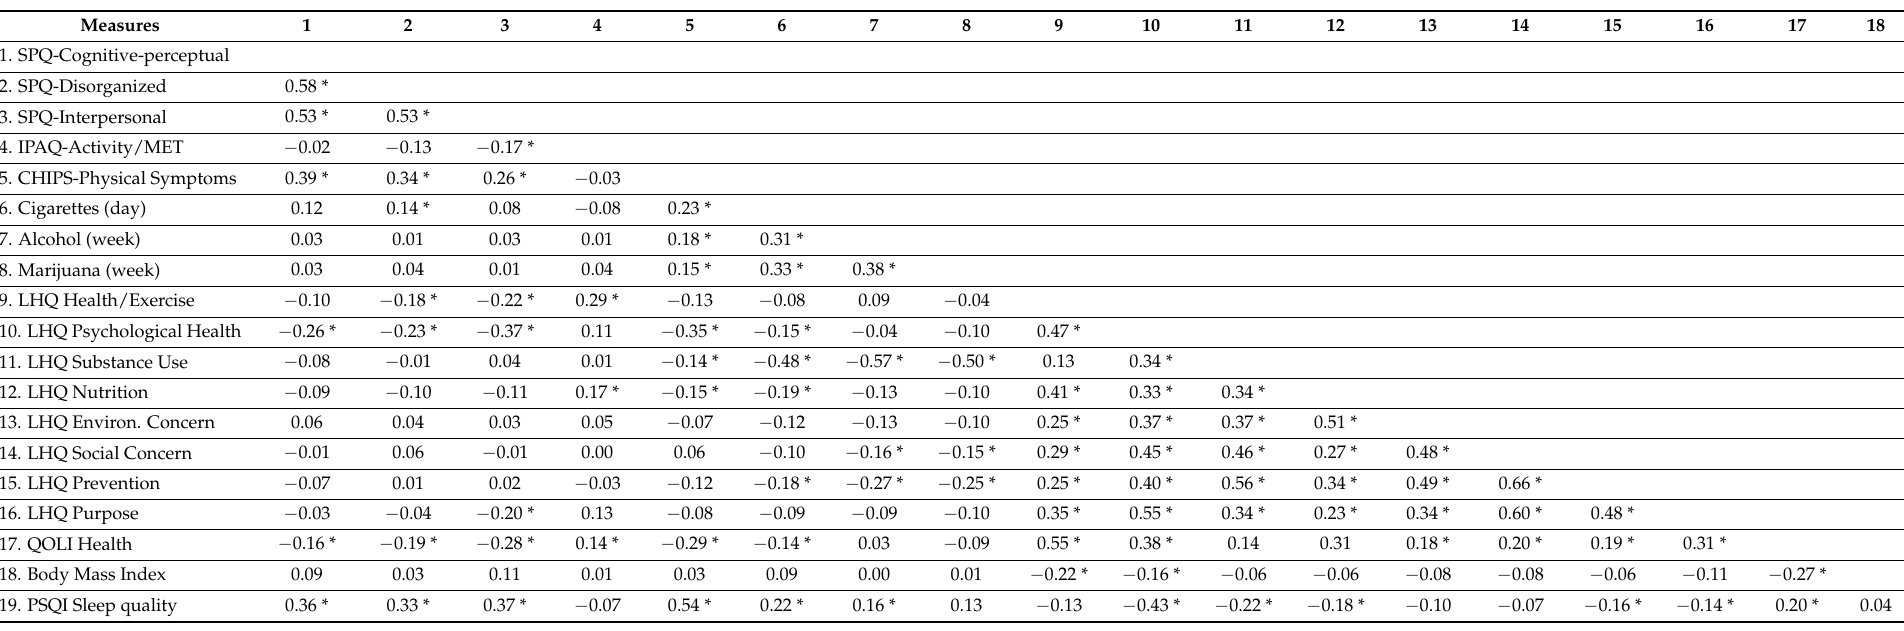
* indicates significance under <0.002. Italicized variables indicate the use of Spearman correlations due to non-normal distributions; SPQ = Schizotypal. Personality Questionnaire-Brief Revised; IPAQ- Activity/MET = International Physical Activity Questionnaire Metabolic Equivalent of Task score; CHIPS = Cohen-Hoberman Inventory of Physical Symptoms; LHQ = Lifestyle and Habits Questionnaire-Brief; QOLI = Quality of Life Inventory; PSQI = Pittsburgh Sleep Quality